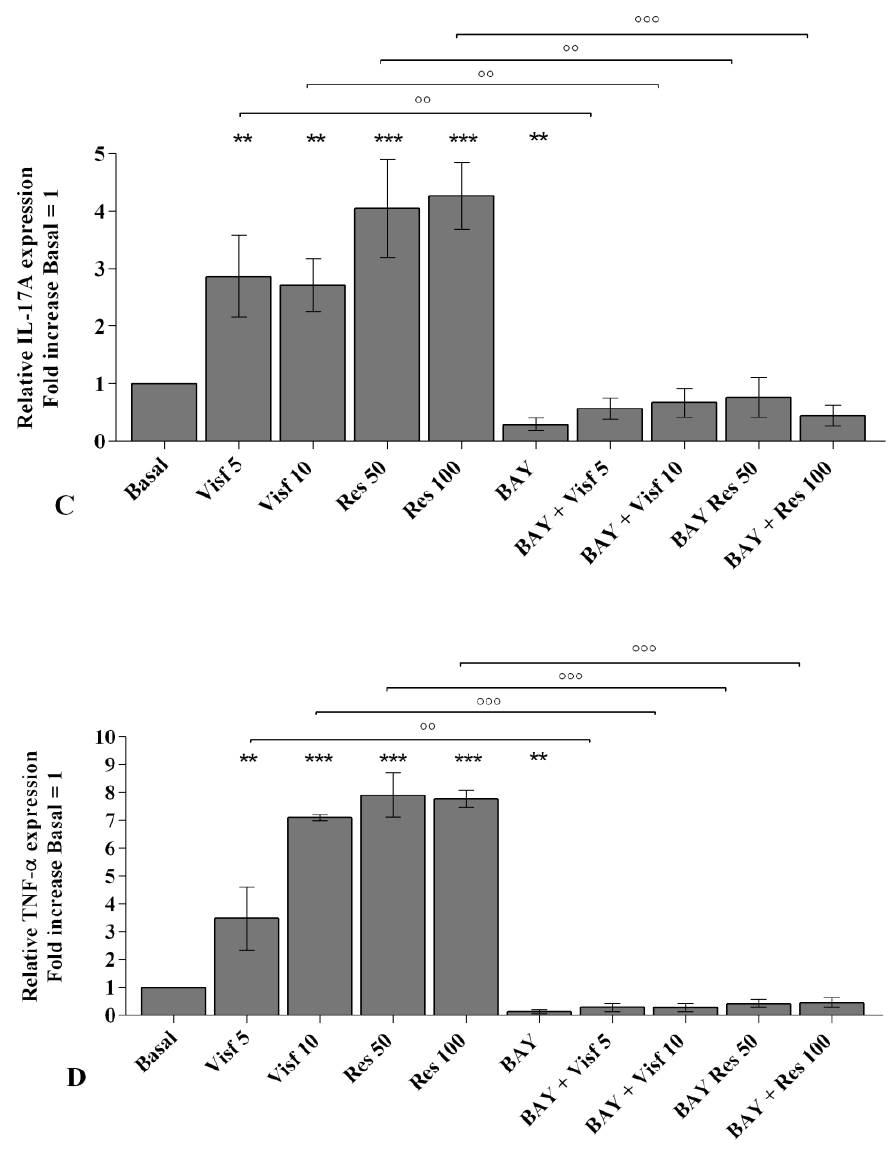
Figure 10. Expression levels of interleukin ( IL )- 1 β ( A ), IL-6 ( B ), IL-17A ( C ), tumor necrosis factor ( TNF )- α ( D ) by real-time PCR. Human osteoarthritic (OA) synovial fibroblasts were evaluated at basal condition, after 2 h pre-incubation with a specific nuclear factor (NF)- κ B inhibitor (BAY 11-7082, IKK α / β , 1 µ M) and after 24 h of stimulus with visfatin (5 and 10 µ g / mL) and resistin (50 and 100 ng / mL). The gene expression was referenced to the ratio of the value of interest and the value of basal condition (basal, cells without treatment) reported equal to 1. Data were expressed as mean ± SD of triplicate values, ** p < 0.01, *** p < 0.001 versus basal condition. ◦◦ p < 0.01, ◦◦◦ p < 0.001 versus BAY. BAY = BAY 11-7082, Visf = visfatin, Res = resistin. A specific NF- κ B inhibitor (IKK α / β , BAY 11-7082) was used to analyze the modulation of